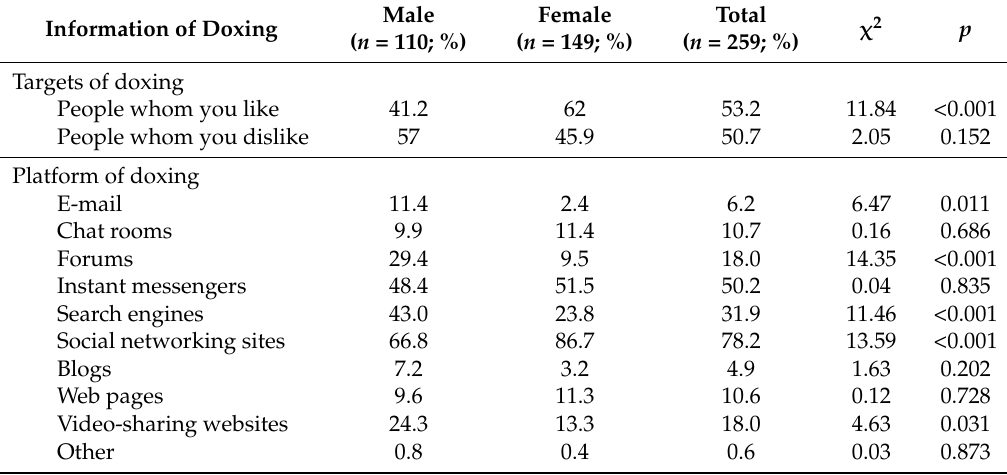
Table 3. Platforms and targets of